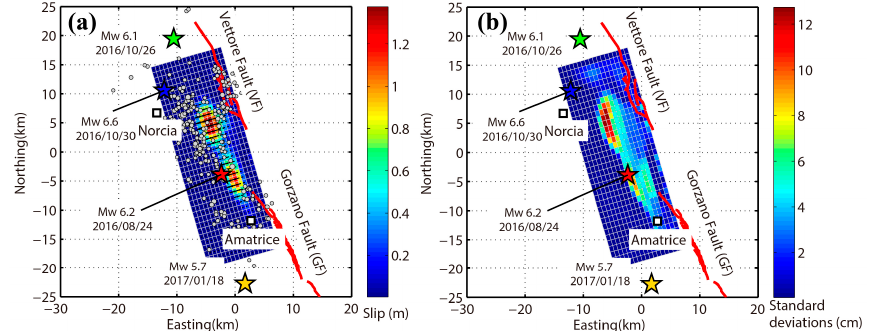
Figure 3. ( a ) Surface projection of the coseismic slip model of 24 August 2016 Amatrice earthquake. ( b ) Standard deviations in slip from Monte Carlo estimation with 100 perturbed datasets. Red lines represent the active fault (GF, Gorzano Fault; VF, Vettore Fault). Gray dots denote the aftershocks of ML > 3 from 24 August to 25 October 2016 [12]. Color shows the slip magnitude in meters, and arrows correspond to the slip directions. White square denotes the city of Norcia and Amatrice. The red star corresponds to the epicenter of 24 August 2016 Italy earthquake, the green star denotes the epicenter of 26 October 2016 earthquake, the blue star denotes the epicenter of 30 October 2016 earthquake and the golden yellow star denotes the epicenter of 18 January 2017 earthquake [12].